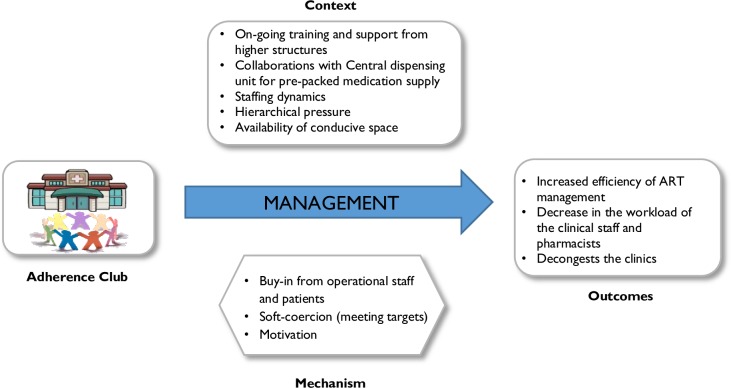
CMO for Managers.